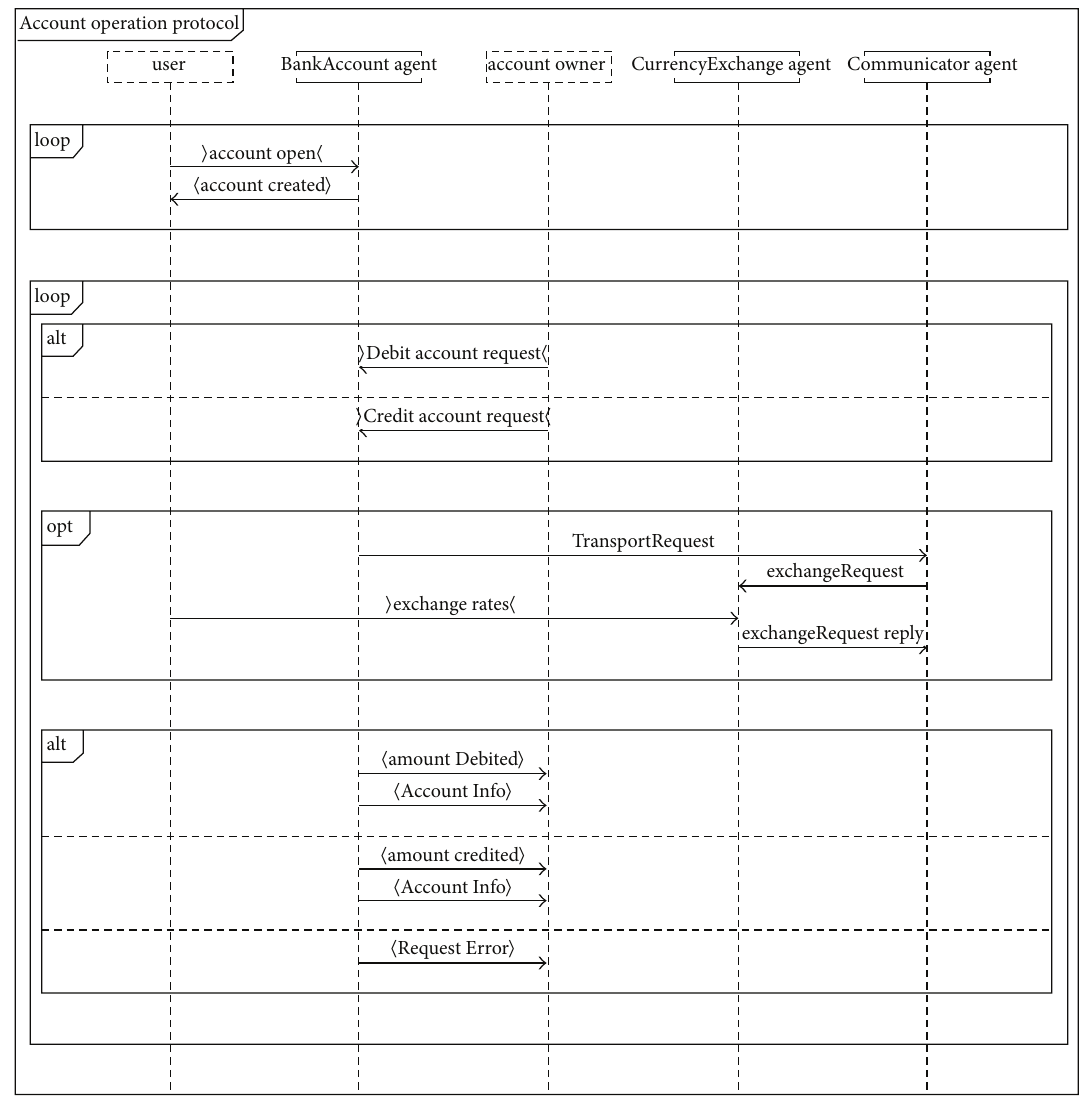
Figure 6: Account operation protocol